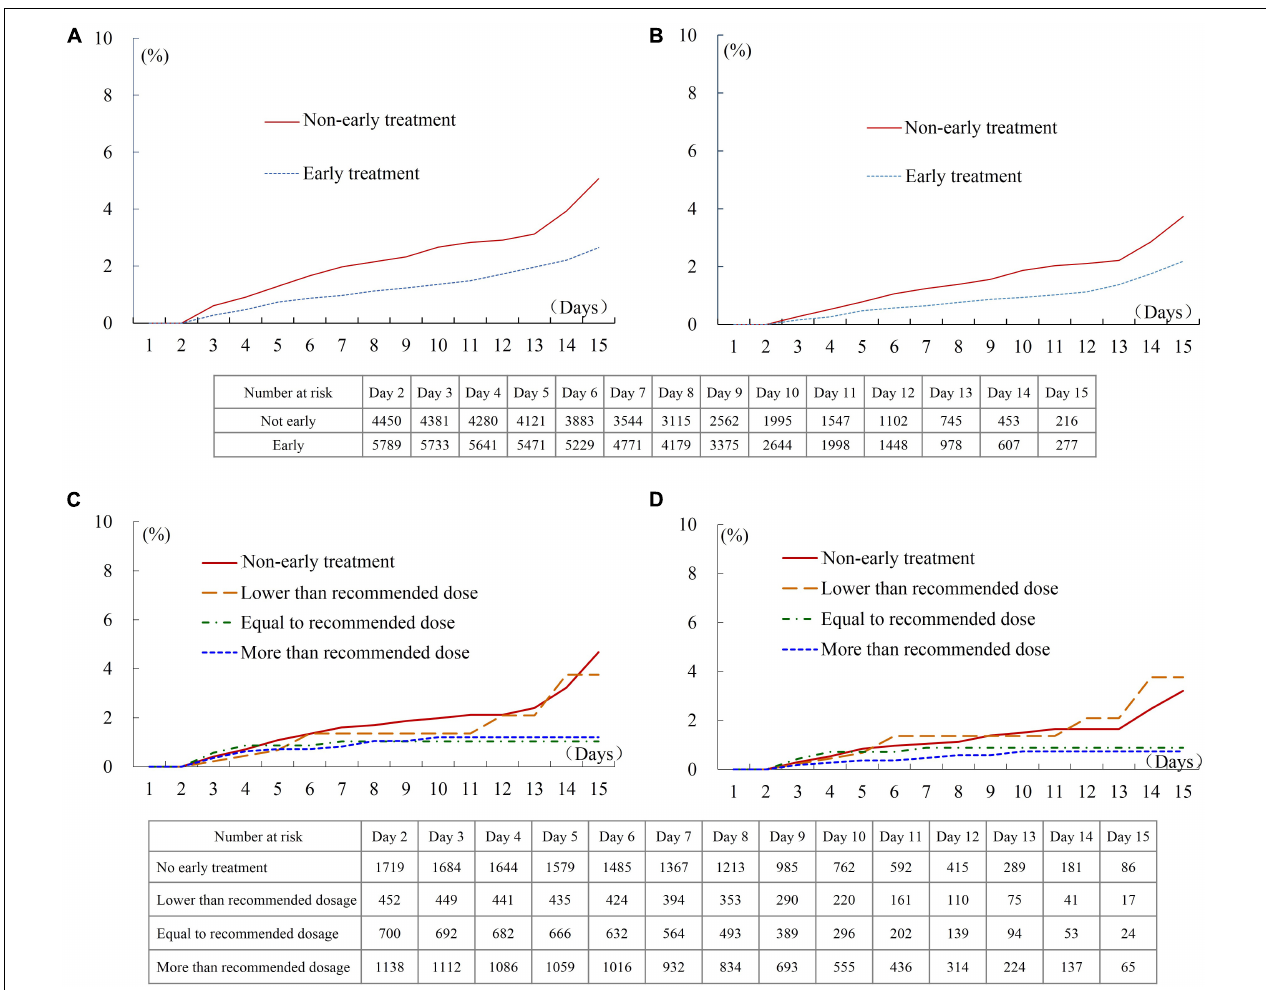
FIGURE 2 | In-hospital outcomes of patients treated with different first-day oral β -blocker dosage. (A) Combined endpoint of patients with and without early therapy. (B) All-cause death of patients with and without early therapy. (C) Combined endpoint of patients treated with different dosages. (D) All-cause death of patients treated with different dosages. Recommended initial dosage of Bisoprolol: 1.25 mg/day, Carvedilol: 6.25 mg/day, Metoprolol succinate: 23.75 mg/day, and Metoprolol tartrate: 18.75 mg/day. TABLE 2 | Multivariate analysis of the effects of early oral β -blocker therapy. After IPTW Cox regression* Propensity score